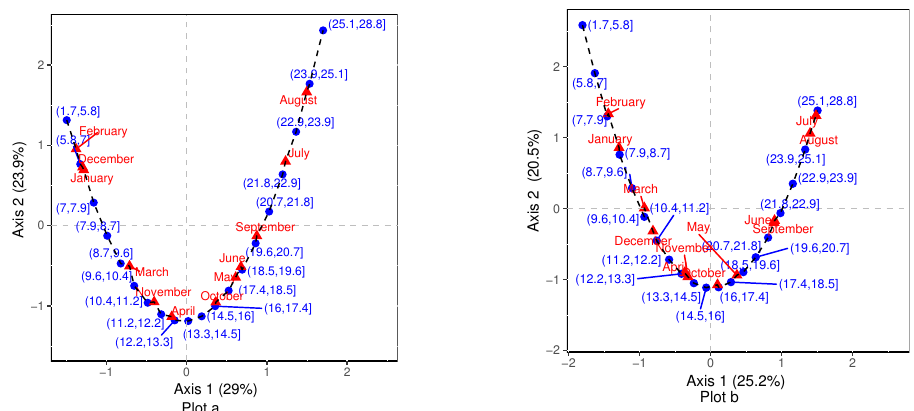
Figure 4. DOCA polynomial biplot. Temperature and month association in Campania. Plot a is reflects the year 1986 and plot b the year 2015.